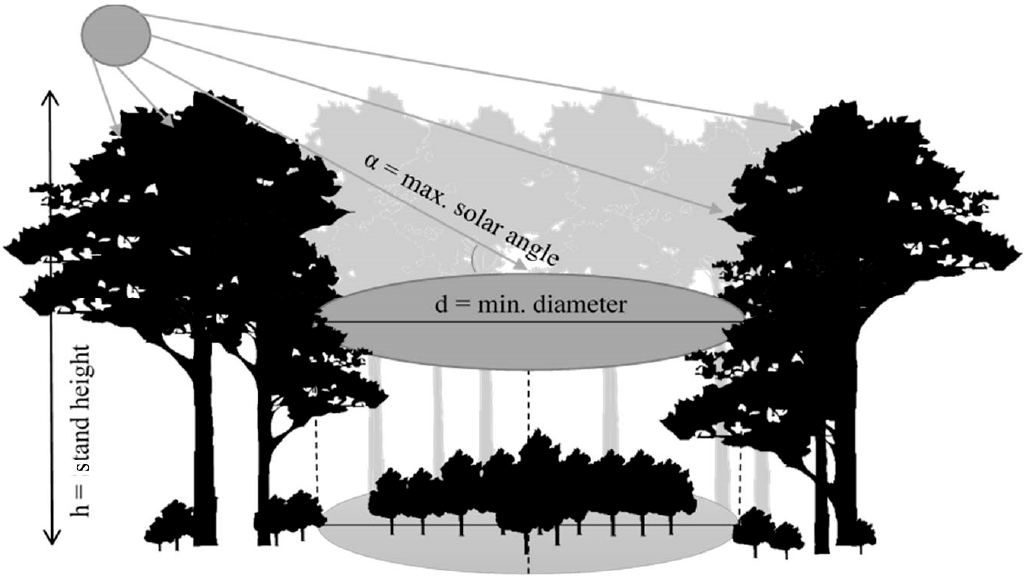
Figure 3. Schematic representation of the relationship between stand height (h) and maximum solar angle ( α ) and the resulting minimum diameter (d) of the canopy gap to allow incidence of direct sunlight.